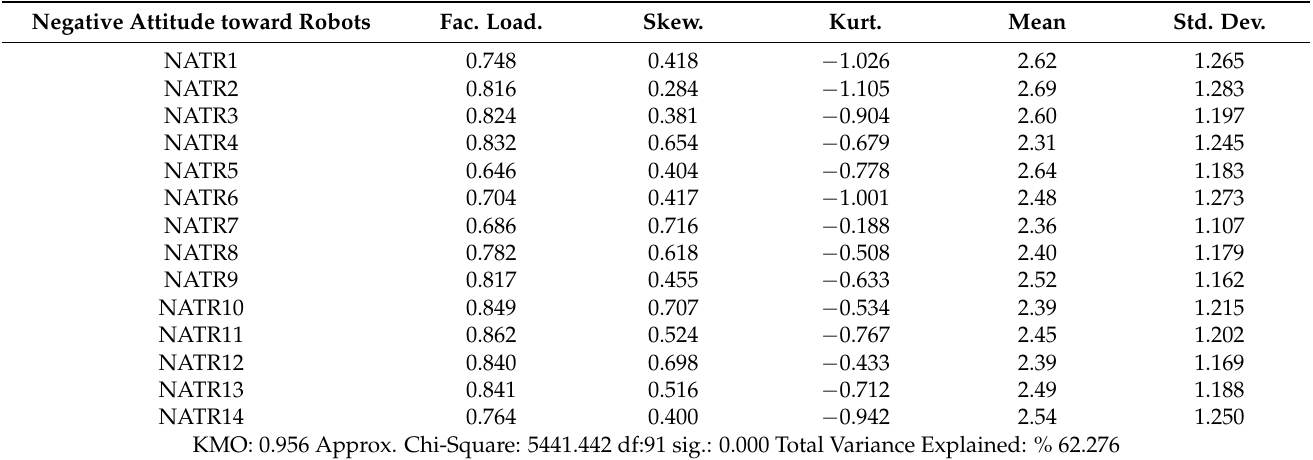
Table 2. Exploratory Factor